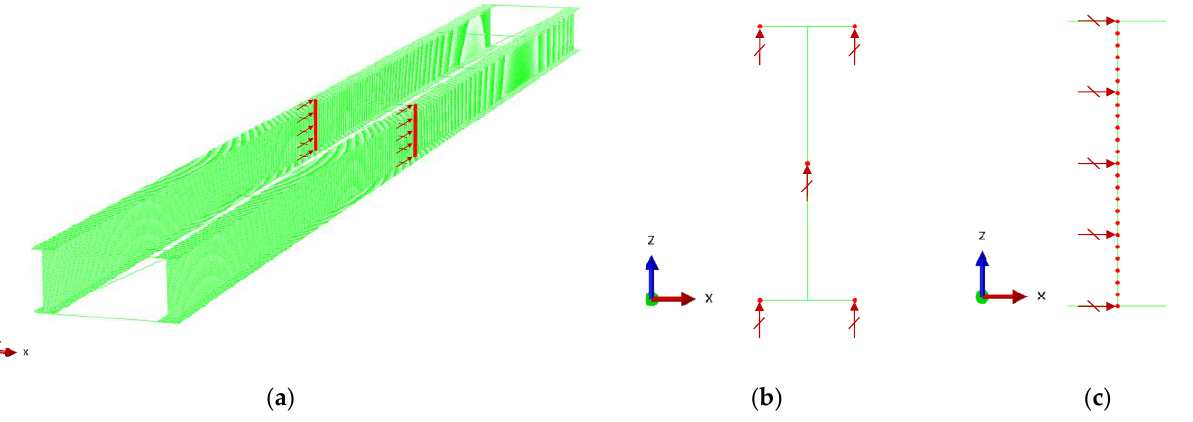
Figure 2. Boundary conditions adopted in the FEA models: ( a ) longitudinal (y-axis) constraints at midpoints; ( b ) vertical (z-axis) constraints at each end; and ( c ) lateral (x-axis) constraints at each end.